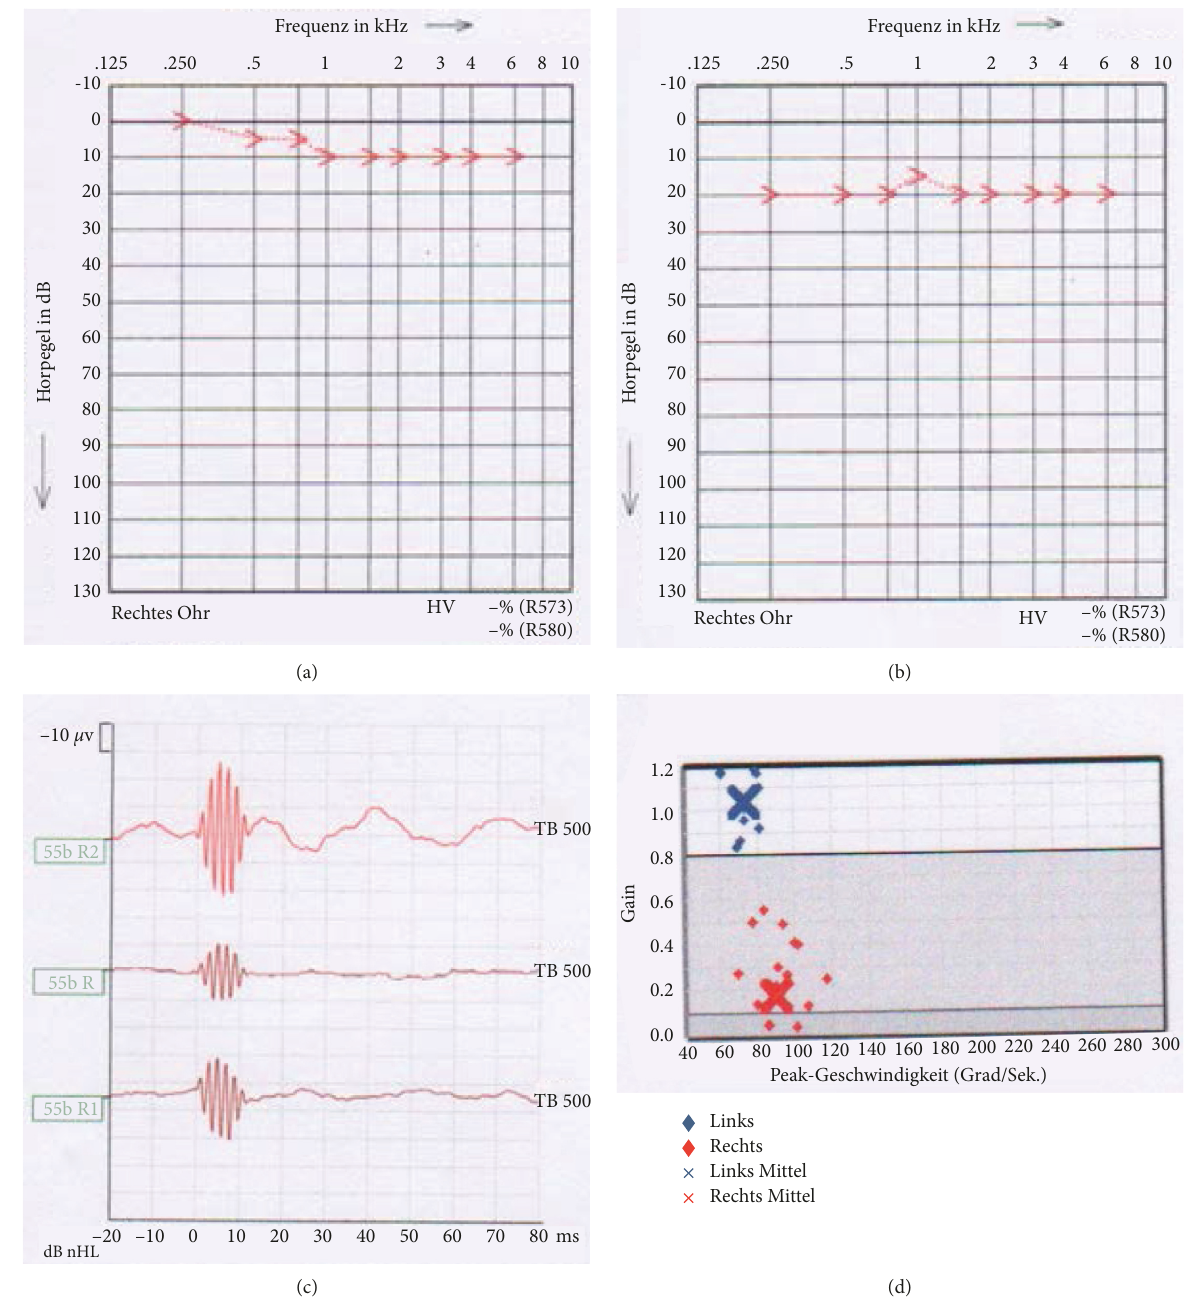
Figure 1: (a) PTA on the 1st postoperative day after tympanoplasty type I on the right and ETD on both sides. Regular BC threshold on the right. (b) PTA on day 5 postoperative tympanoplasty type I right and ETD bilateral. BC drop of 10–20dB pantonal right. (c) No response when examining the cVEMP. (d) vHIT of the lateral semicircular canal. Right gain of 0.18, left